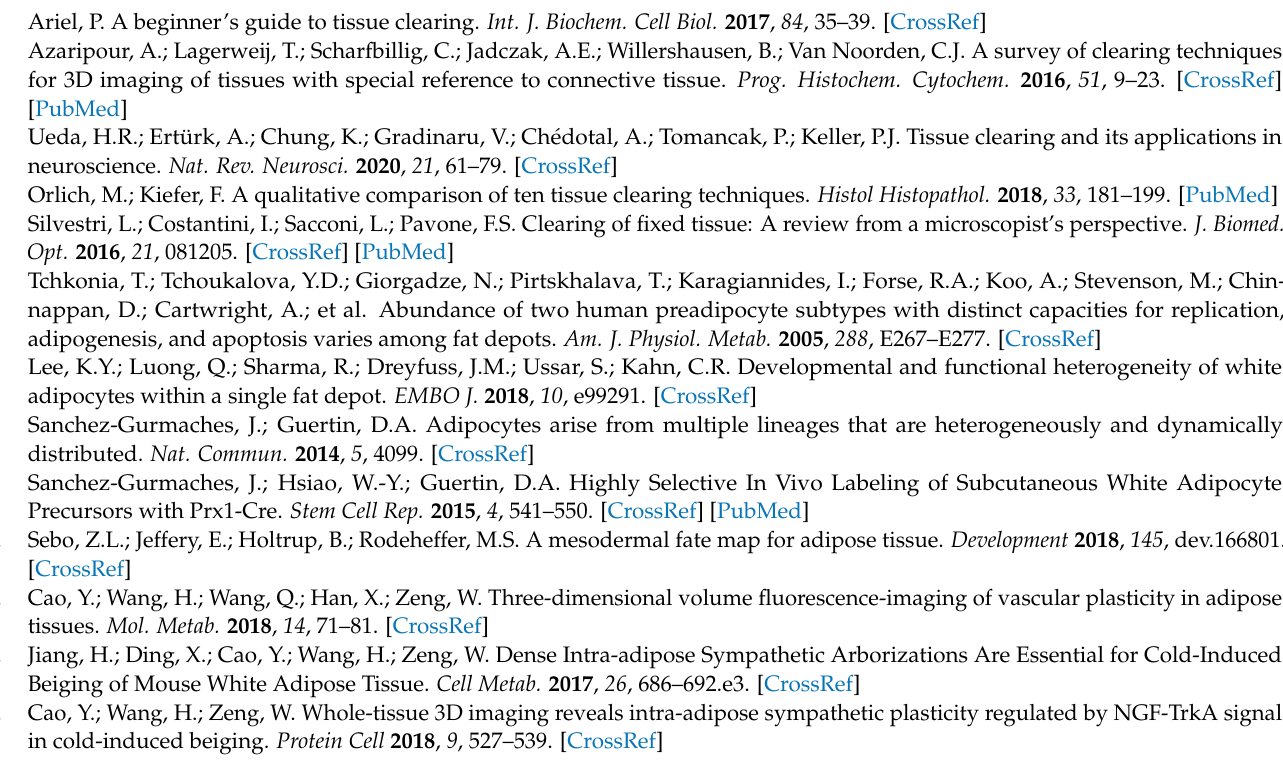
Figure S3: The optimized clearing protocol successfully labelled Type-1 adipocytes in the perigonadal fat of 6-week-old Wt1-cre ERT2 /ROSA26 mTmG mice. Figure S4: Confocal whole mount fluorescent imaging of mesenteric fat confirms finding of the tissue clearing technique that Type-1 adipocytes are associated with the ileum and colon. KDE